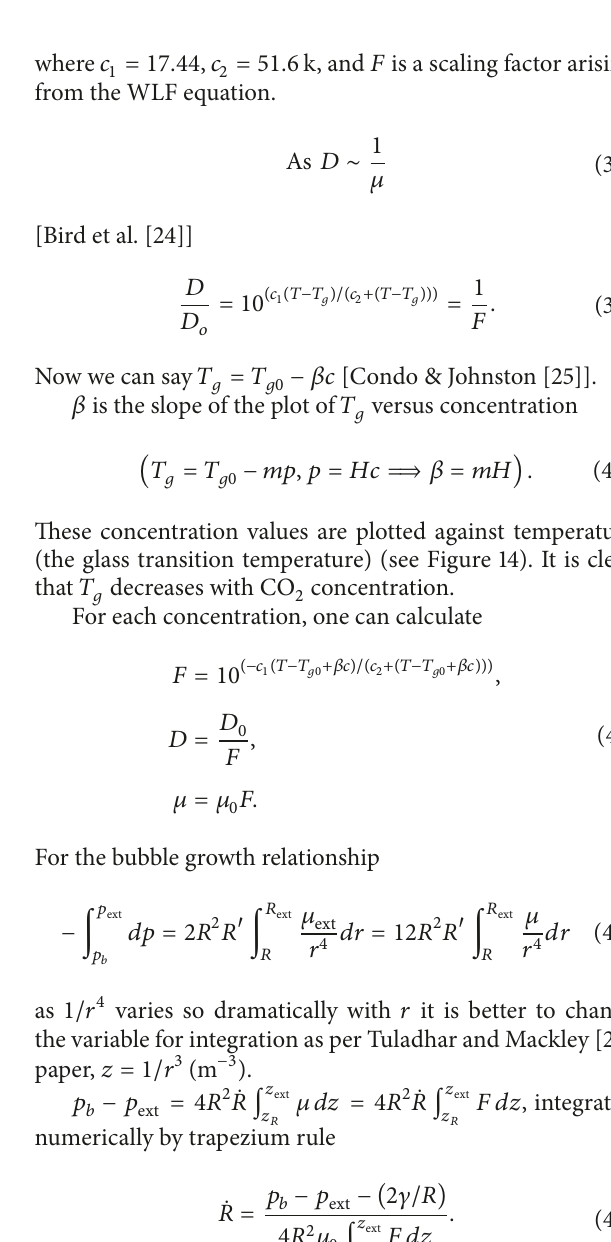
Figure 14: Variation of glass transition temperature of PS with the concentration of CO 2